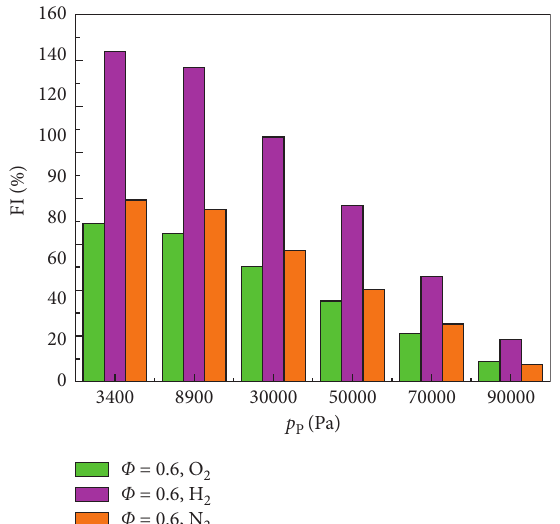
Figure 9: Flux improvement efficiency of four noncondensable gas under different pressure of the permeate side. T V F,in � 0.145m/s, V P,in � 0.002m/s, P F � P 0 , W NaCl �